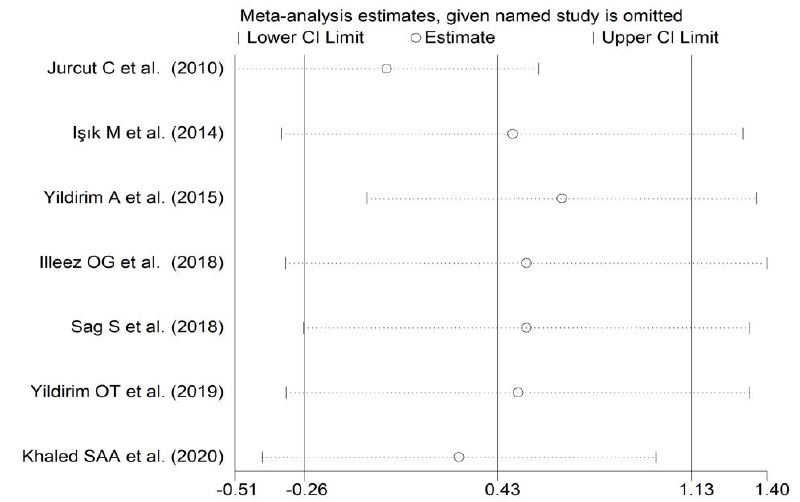
Figure 8. Forest plot of studies examining the platelet distribution width in patients with rheuma- toid arthritis and healthy controls.